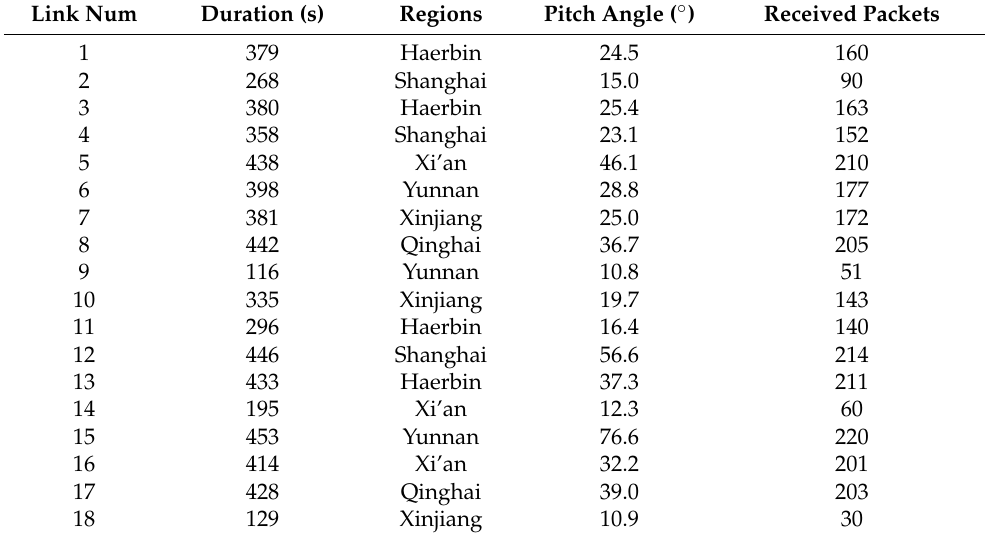
Table 7. Reception schedule in a